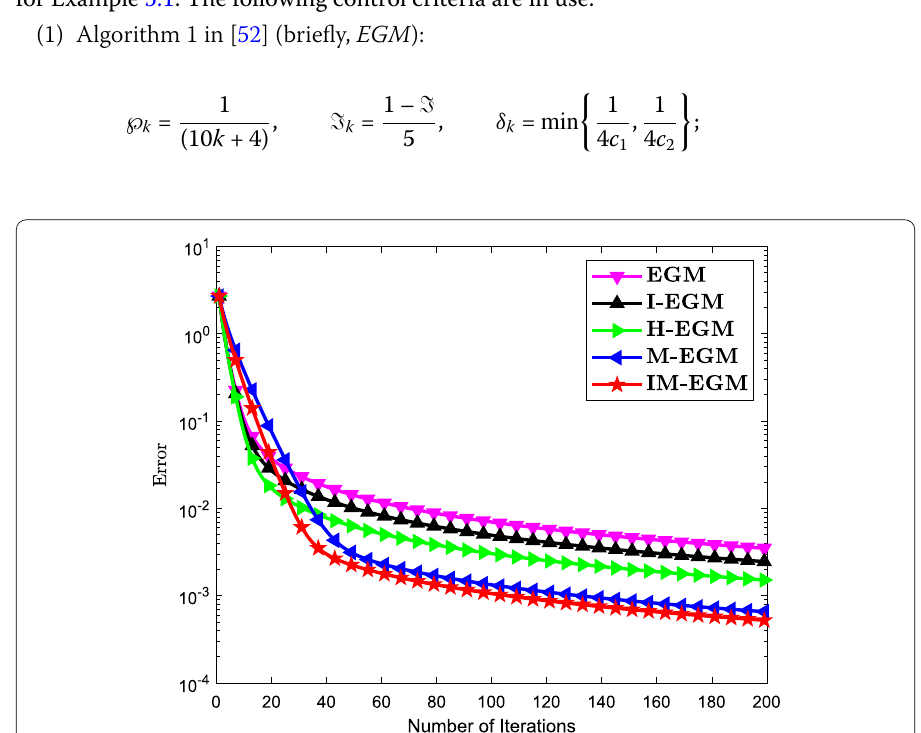
Figure 1 Numerical comparison of Algorithm 1 and Algorithm 2 using Algorithm 1 in [52], Algorithm 2 in [51], and Algorithm 1 in [18], while N = 10 for the first 100